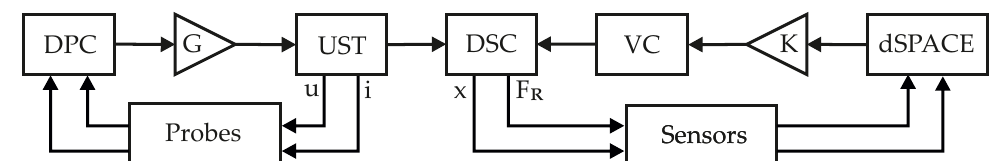
Figure 2. Control loops implemented in the novel